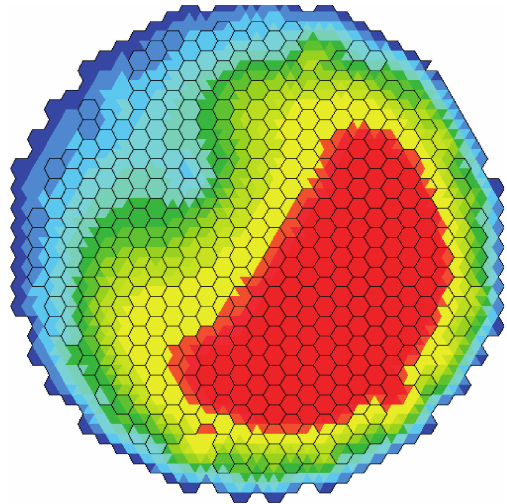
Figure 5: TZ model of CNA